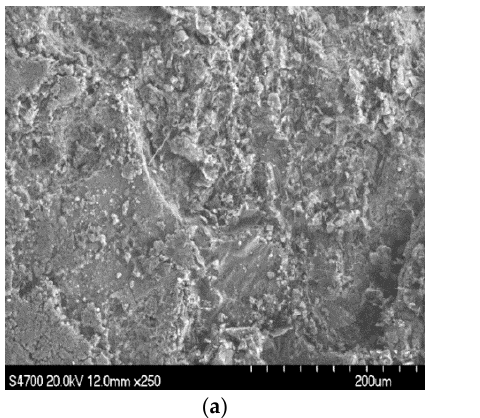
Figure 8. XRD images of the samples. 3.1.3. Failure Analysis According to the surface morphology of the elbow and the elemental analysis of cor- rosion products, the micro holes could be observed on both the inner and outer wall of the first plate of the elbow, and only the mass loss on the outer wall was serious. The EDS and XRD tests indicate that H 2 S corrosion occurs in the elbow and the major corrosion products were FeS 2 and FeS. From the SEM test, the corrosion products were poorly bonded to the surface, and the droplets collided with the wall and carried the corrosion products away from the wall, causing damage to the material. In all, the gas–liquid two- phase erosion–corrosion is the main cause of elbow leakage, and the mechanism of the erosion–corrosion will be discussed by the CFD simulation in Section 3.2.